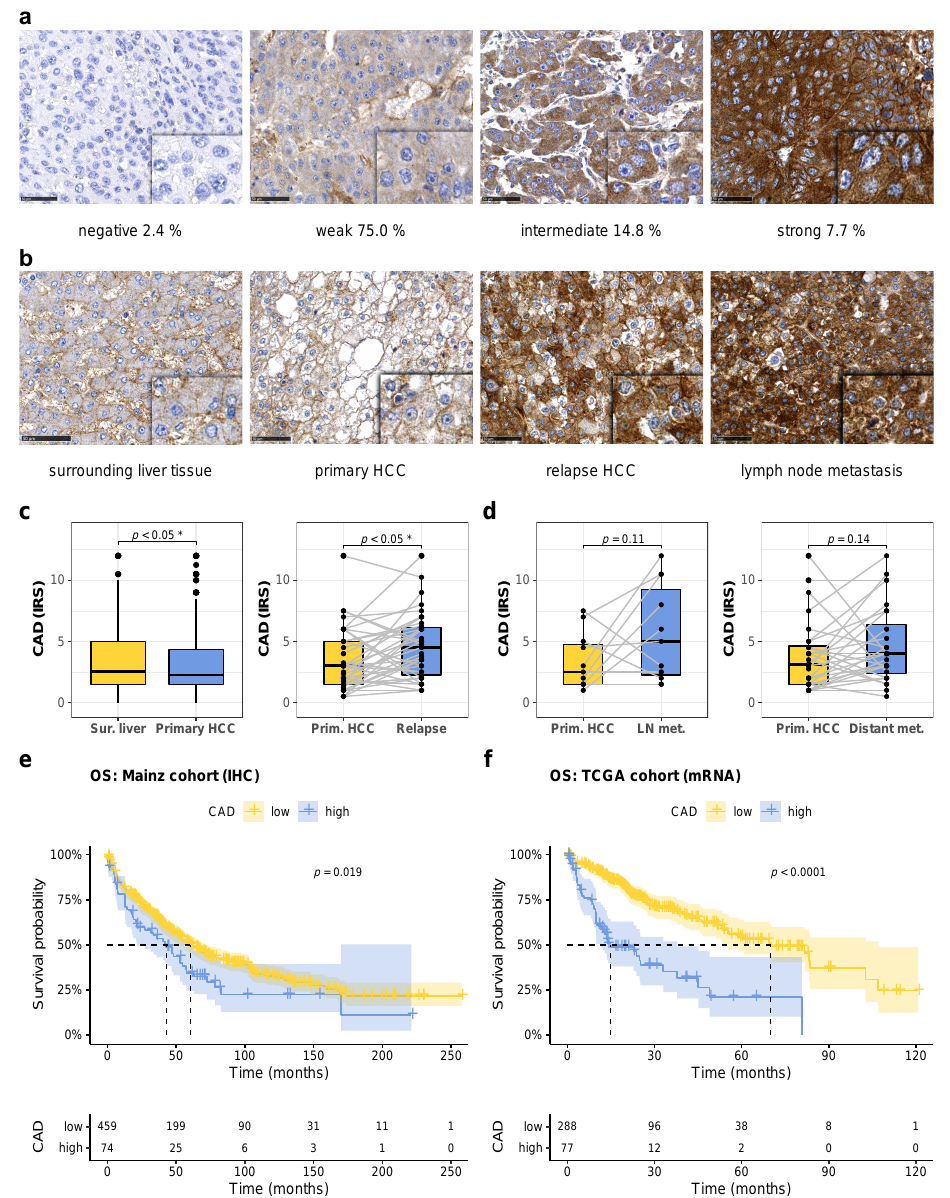
Figure 1. CAD is induced in recurrent hepatocellular carcinoma and predicts prognosis. ( a ) Rep- resentative images of immunohistochemical staining of primary HCCs with different expression levels of CAD. The percentage of tumors with the indicated expression level is shown. Scale bar: 50 µ m. ( b ) Increased expression of CAD during tumor progression. Immunostainings for CAD in surrounding liver tissue, primary and relapse HCC, and lymph node metastasis of one individual patient. Scale bar: 50 µ m. ( c ) Quantitative analysis of CAD expression (immunoreactive score, IRS) in primary HCC compared to non-neoplastic surrounding tissue (left panel, surrounding liver: n = 530, HCC: n = 533) and in recurrent HCC compared to primary HCC (right panel, n = 39); * p ≤ 0.05. ( d ) Quantitative analysis of CAD expression in primary HCC compared to lymph node metastasis (left panel, n = 11) and distant metastasis (right panel, n = 28). ( e ) Kaplan–Meyer plot displaying overall survival with respect to high and low CAD protein expression as detected by immunohisto- chemistry (HR 1.44, 95% confidence interval 1.06–1.95, p = 0.019). ( f ) Kaplan–Meyer plot displaying overall survival with respect to high and low expression of CAD mRNA in the TCGA cohort (HR 3.31, 95% confidence interval 2.28–4.82, p ≤